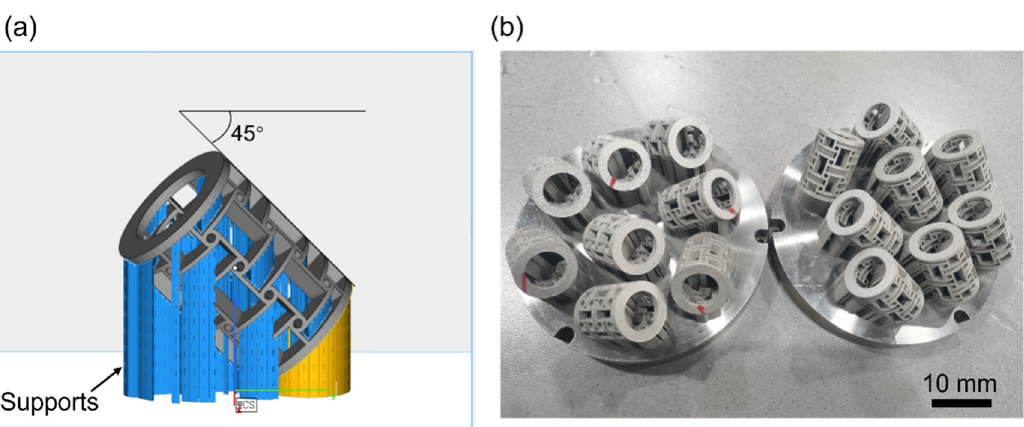
Figure 2. ( a ) Schematic diagram of the support model; ( b ) as-fabricated anti-tetrachiral stents.